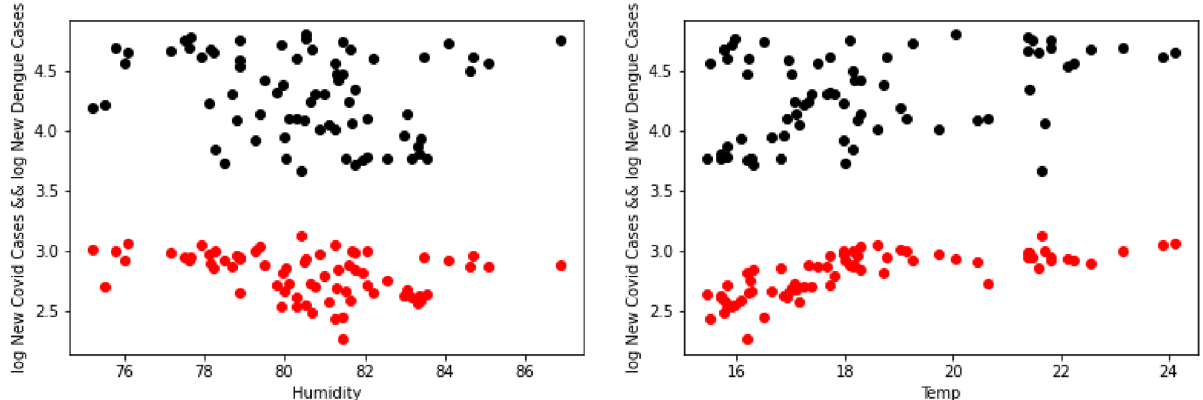
Figure 6. Humidity correlations (left) and temperature correlations (right) for Perú’s